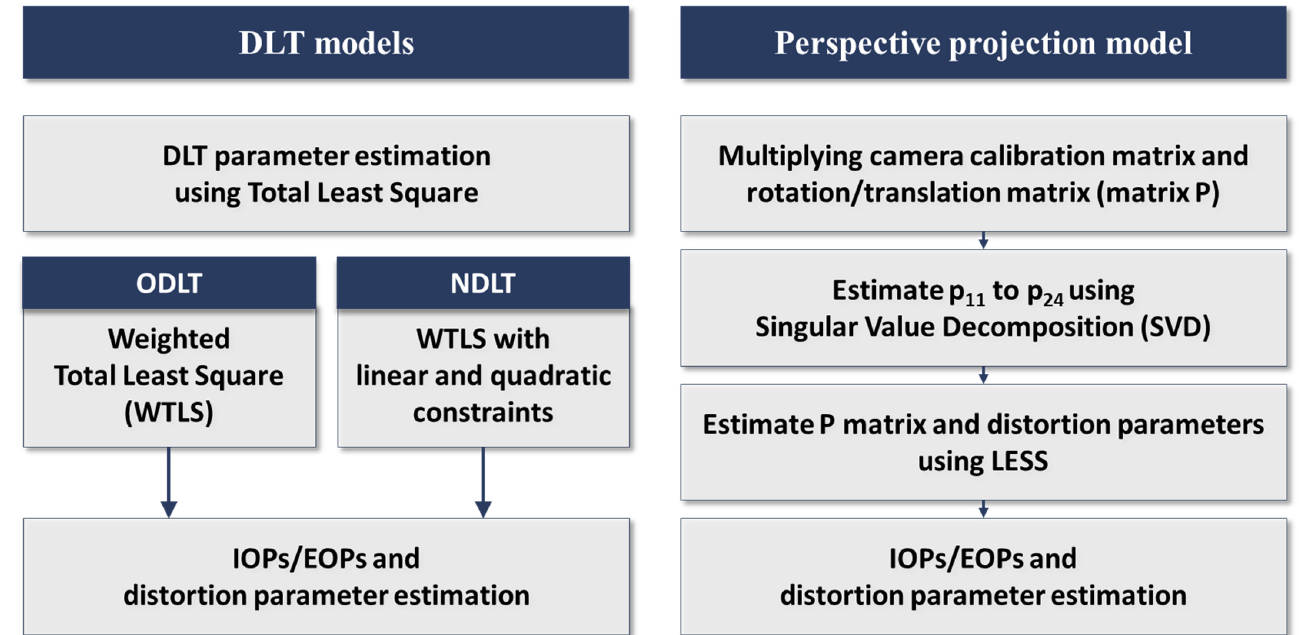
Figure 2. Process of estimating IOPs/EOPs using DLT model and perspective model.